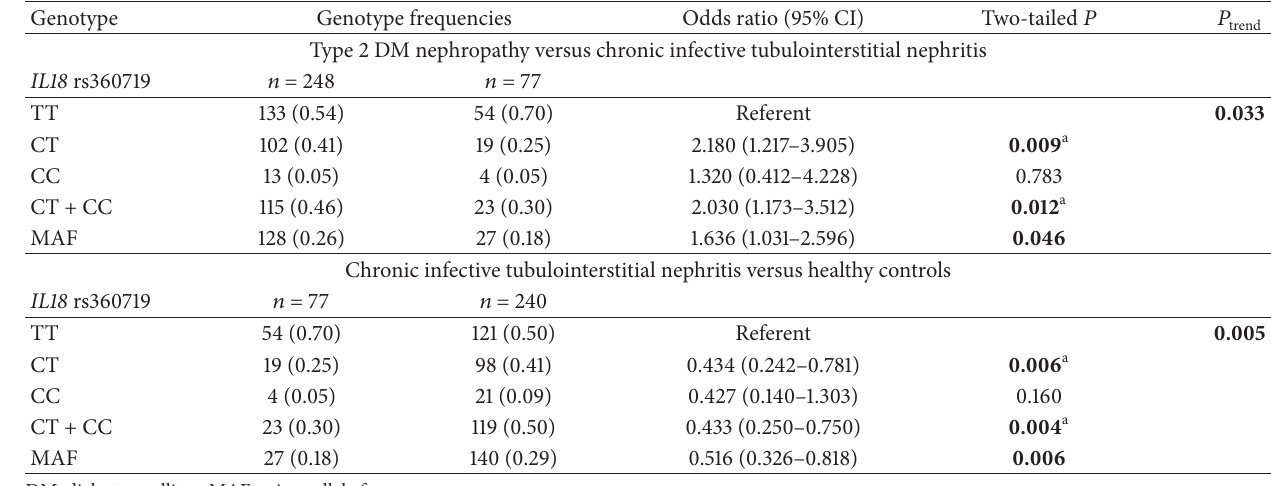
Table 6: Selected comparisons of the polymorphic variants distribution of tested genes between type 2 DM nephropathy patients, chronic infective tubulointerstitial nephritic patients, and healthy